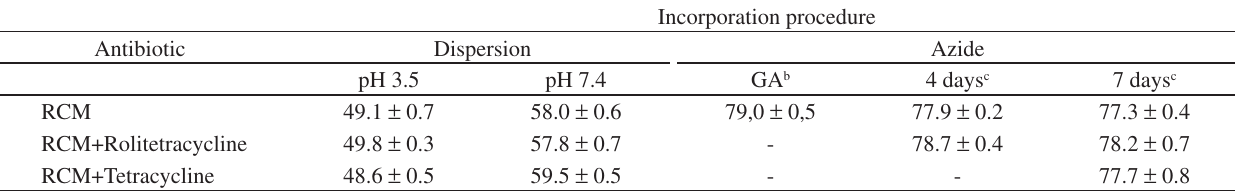
Table 1. Shrinkage temperature a (Ts, ° C) of reconstituted collagen membranes without and with antibiotics incorporated by dispersion or by covalent im- mobilization by azide procedure.